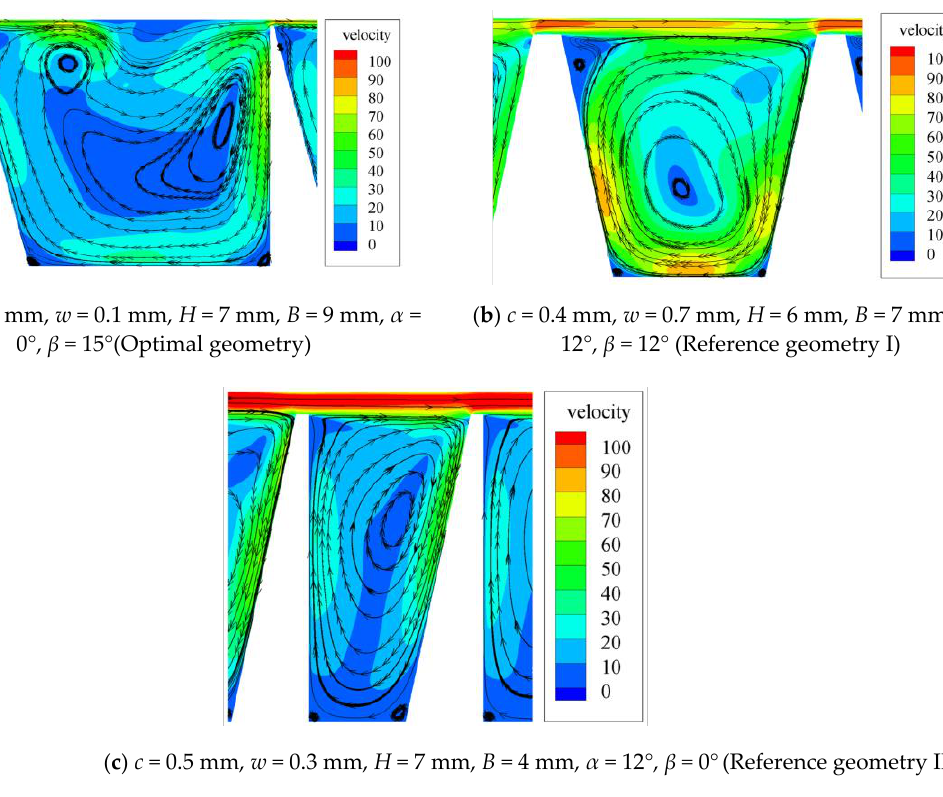
Figure 9. Distribution of gas velocity in the second seal cavity (Unit: m/s).